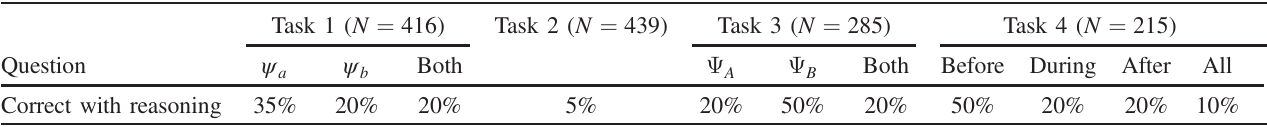
TABLE I. Percentage of junior-level students who gave correct answers (with correct reasoning) for each of the four research tasks (see Fig. 1). Results are shown for the individual parts of each task and for each task as a whole. Data are aggregated across all courses in which each task was administered after relevant lecture instruction but before tutorial instruction.